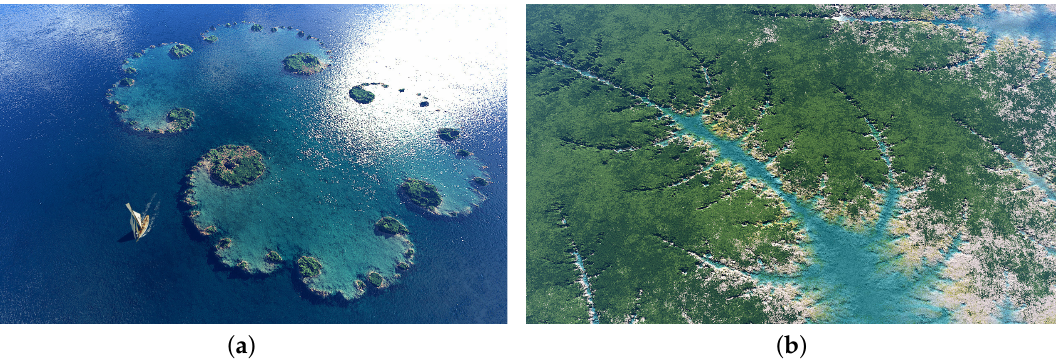
Figure 6. ( a ) Julia island (Image source: https://en.wikipedia.org/wiki/Terragen, accessed on 22 June 2022) and ( b ) Mandel river (details of the Mandelbrot set) rendered by Terragen Classic. (Image source: https://en.wikipedia.org/wiki/Fractal-generating_software, accessed on 22 June